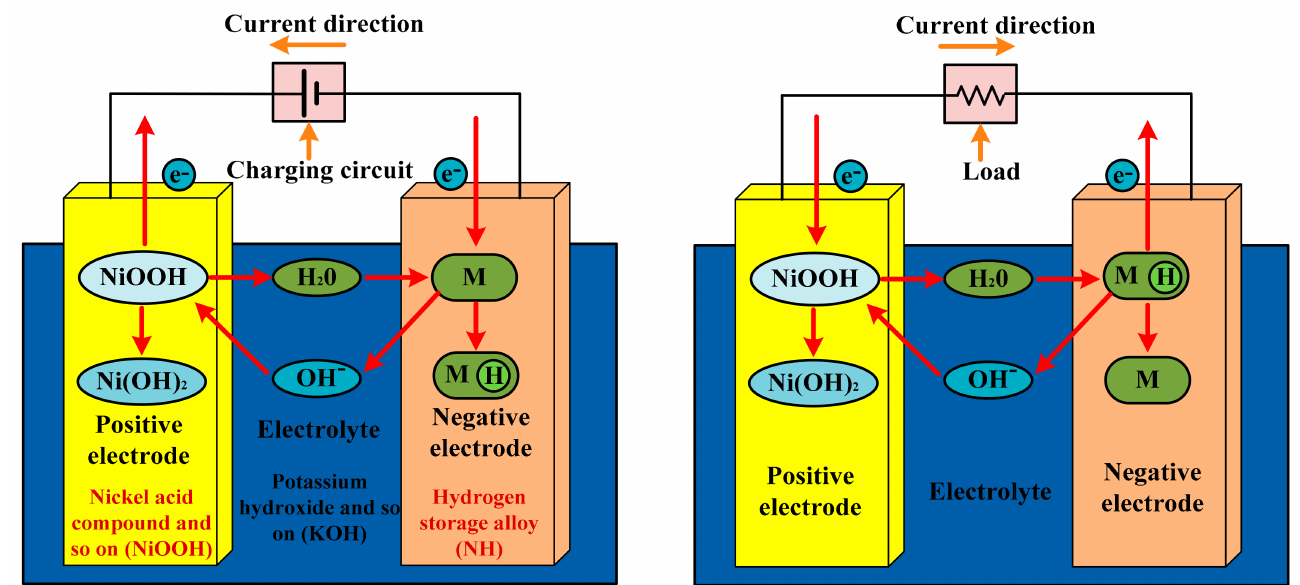
Figure 9. Charging and discharging of Ni–Cd